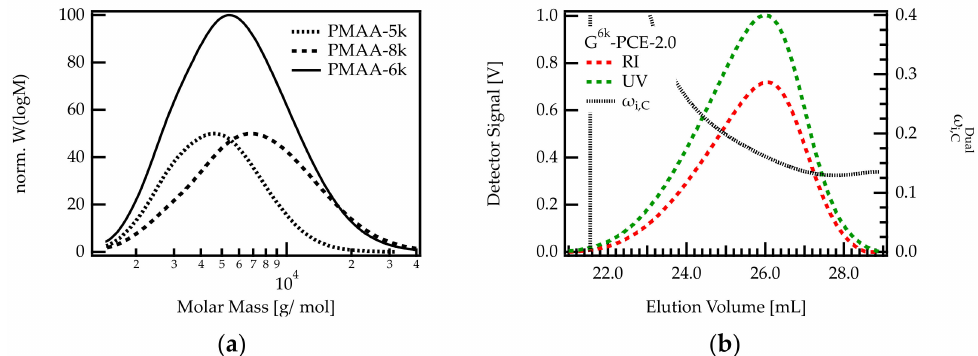
Figure 6. ( a ) Molar mass distributions of PMAA. PMAA-5k was used for the G-PCEs shown in Table 1. The molar mass range of this PCE was increased by adding PMAA-8k. The resulting backbone mix contains PMAA molecules with molar masses between approximately 100 and 40,000 g/mol. ( b ) Dual detection SEC analysis of